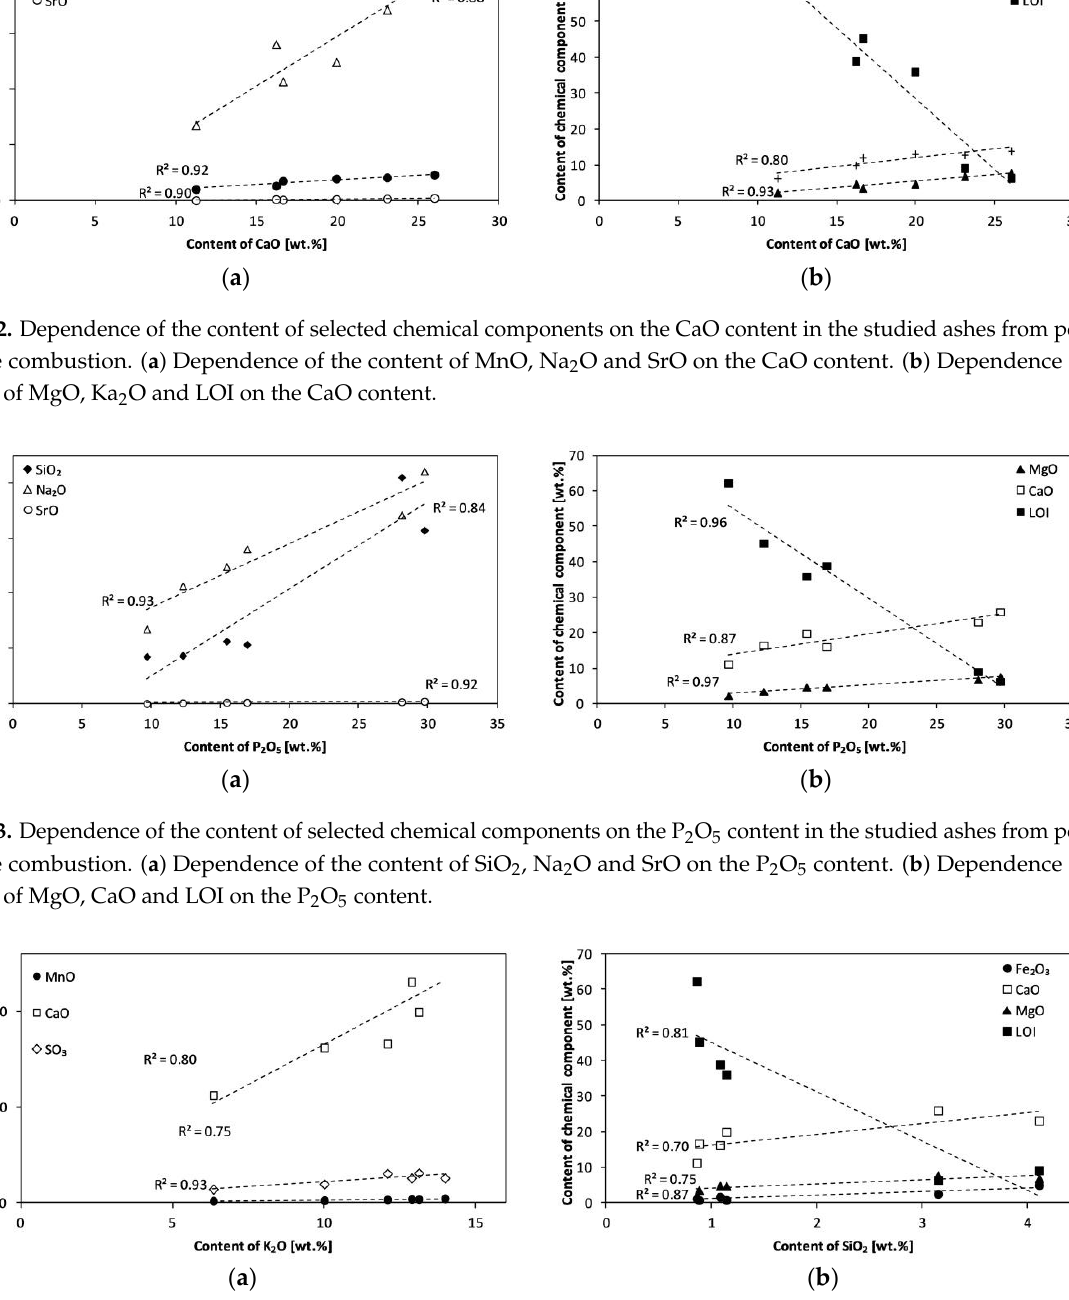
Figure 4. Dependence of the content of selected chemical components on the K 2 O or the SiO 2 content in the studied ashes from poultry manure combustion. ( a ) Dependence of the content of MnO, CaO and SO 3 on the K 2 O content ( b ) Dependence of the content of Fe 2 O 3 , CaO, MgO and LOI on the SiO 2 content.